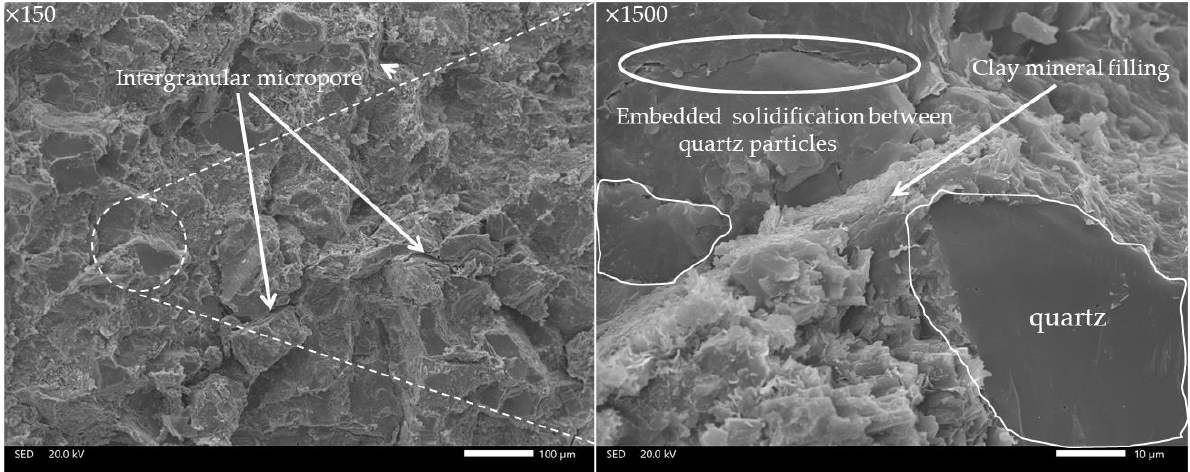
Table 3. Results of particle size analysis of natural red-bedded soft rock.